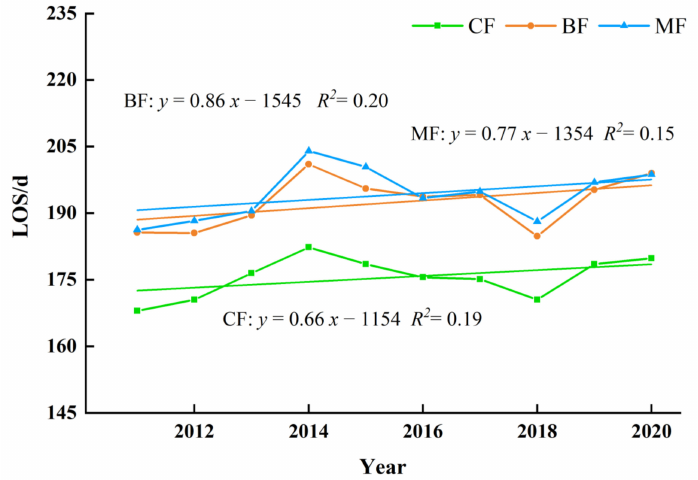
Figure 16. Interannual changes of LOS in different forest types from 2011 to